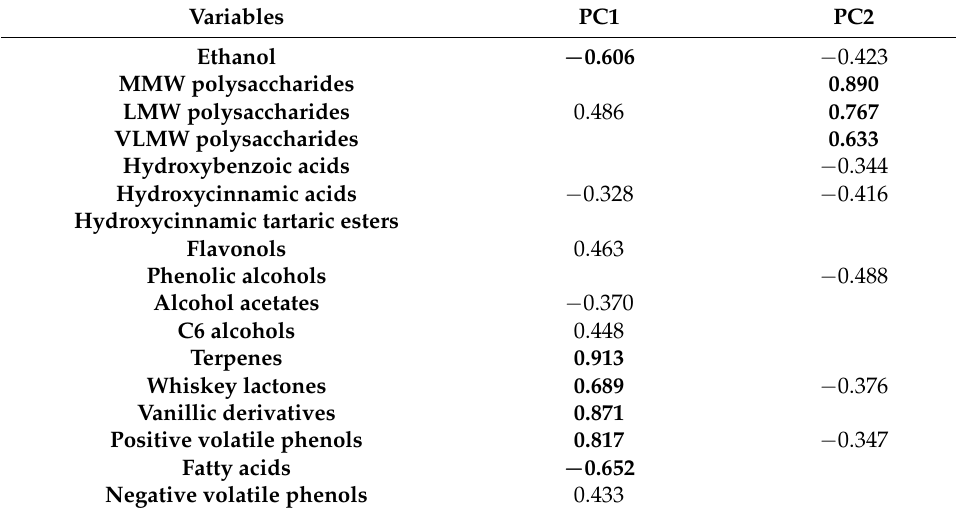
Table 5. PCA loading values of the variables selected in ros é